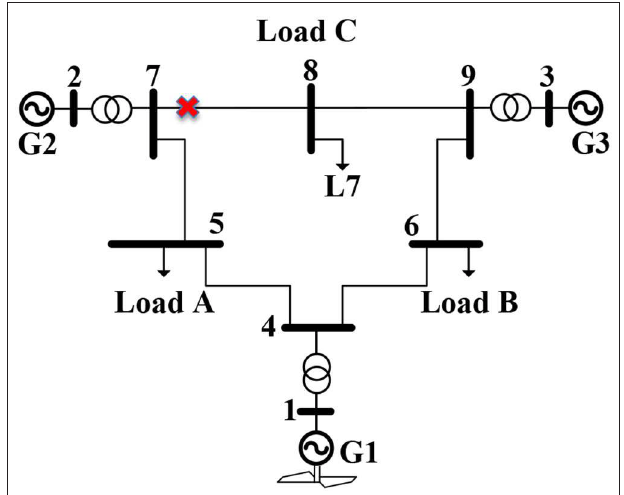
FIGURE 2 | Modified IEEE 9 bus system.